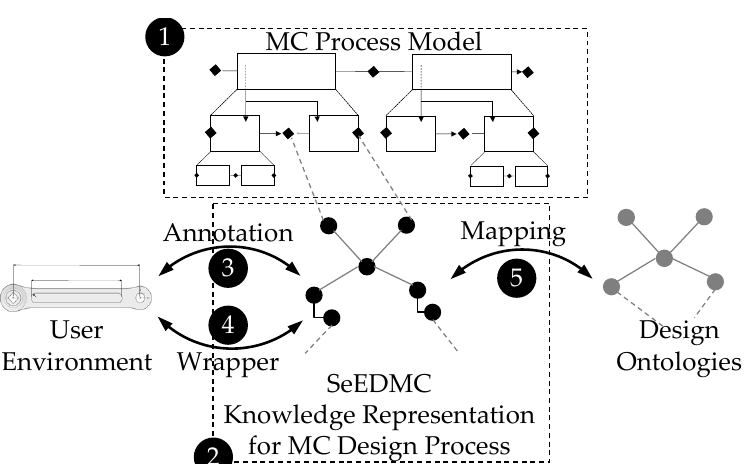
Figure 1. Illustration of the approach consisting of the model used for the MC process (1), its knowledge representation (2, SeEDMC), its integration into the development environment via an annotation scheme (3) and a wrapper (4), as well as the integration into existing knowledge representations with the help of a mapping scheme